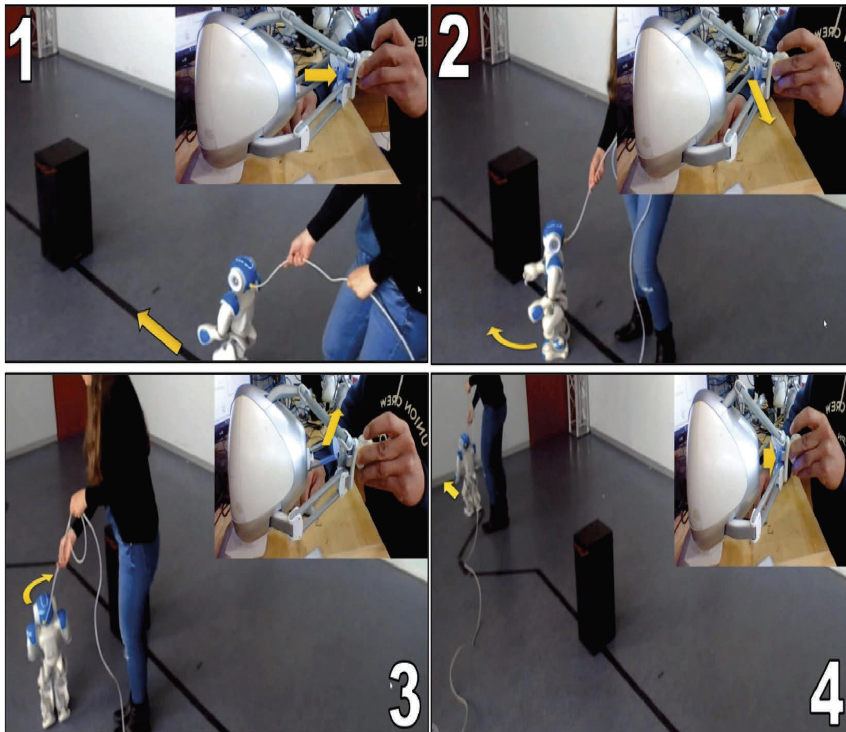
Figure 10: Test workspace and task to be